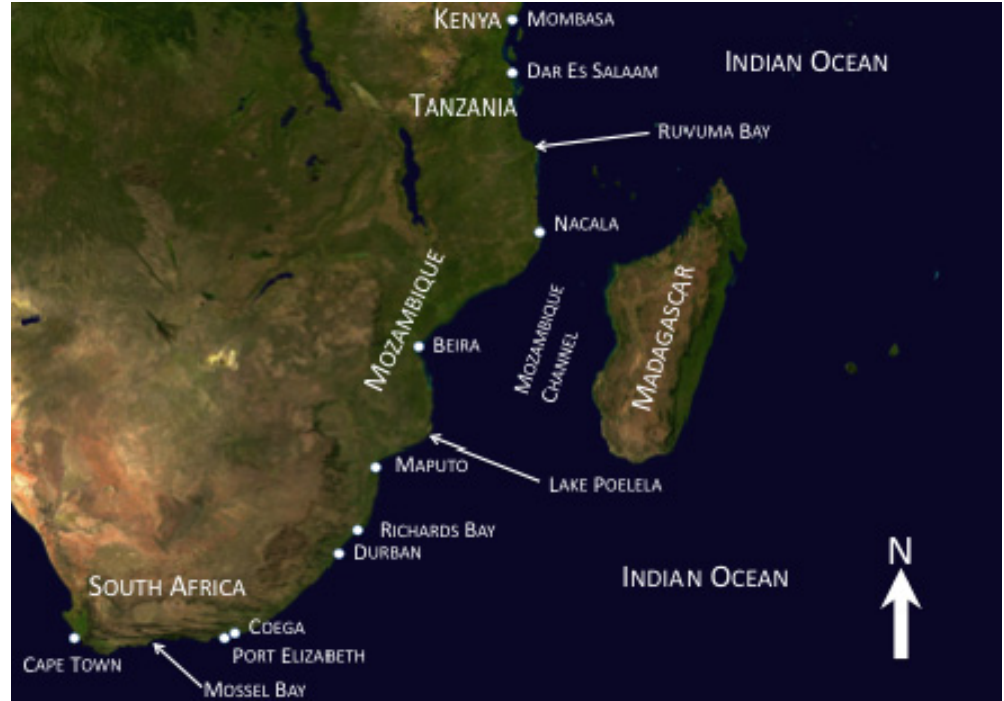
Figure 1. Regional map with place names referred to in the text. The case study is located in Durban (Source: Adapted from NASA